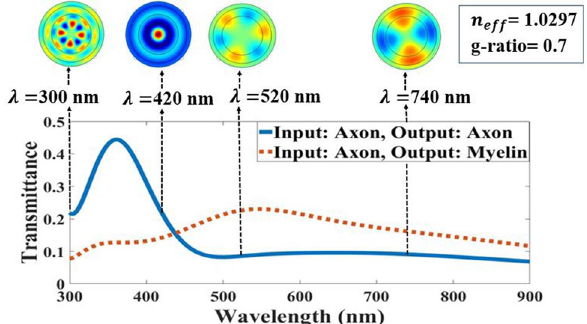
Figure 10. Light transmission spectra in two states of axon and myelin outputs for g-ratio = 0.7 with axon guided modes in 300 nm, 420 nm, 520 nm, and 740 nm wavelengths in light coupling to